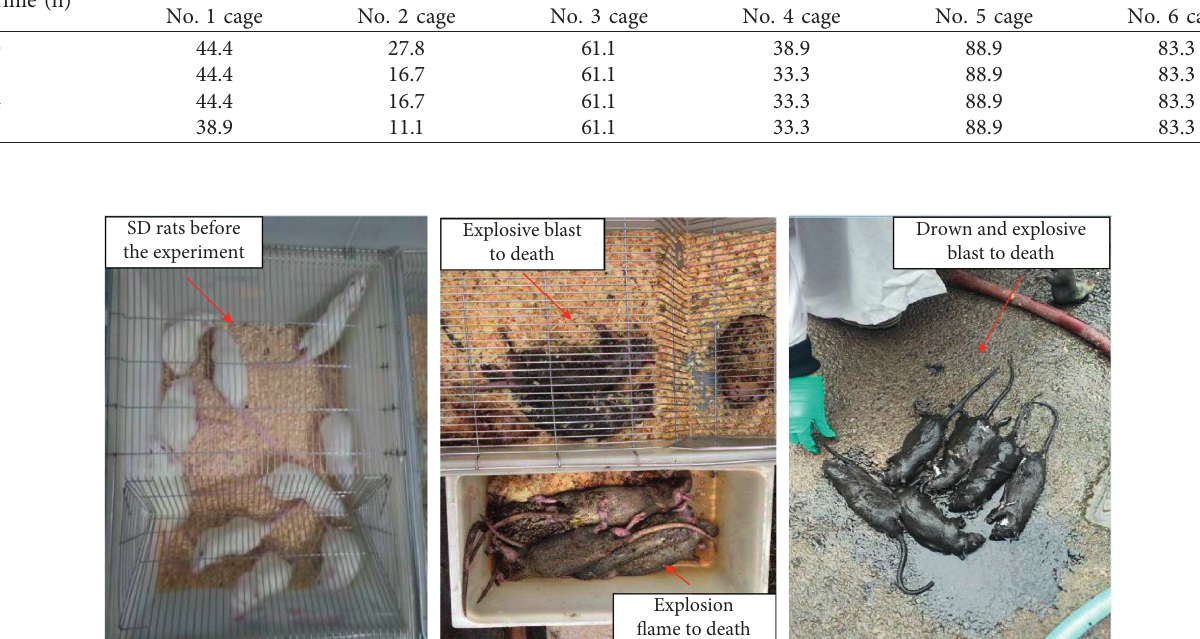
Figure 11: Comparison of SD rats before and after the gas explosion.